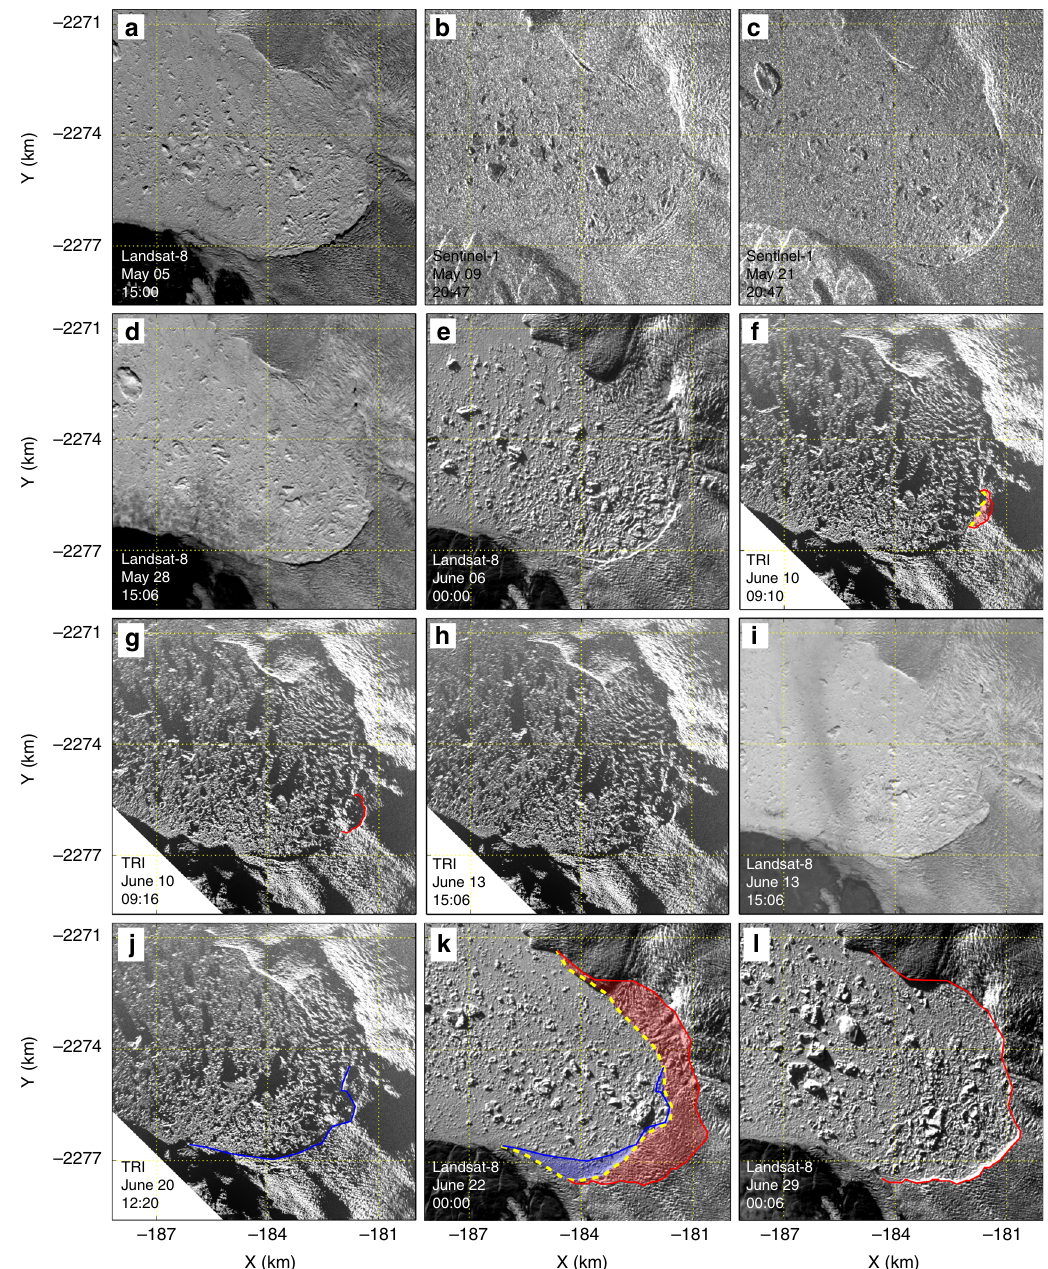
Fig. 3 Ice loss due to glacier calving events by inspection of TRI and satellite images. For each subplot, lower left text gives platform of data source and acquisition time in 2016. In f , dashed yellow line shows a cliff segment which later retreated to the red lines shown in f and g , red shade shows the ice loss area due to that small calving event between f and g . Blue lines in j and k show cliff location at 12:20 20 June 2016. Red lines in k and l show location of the cliff at 00:06 29 June 2016. Dashed yellow line in k shows cliff location at 00:00 22 June 2016. Shaded blue and red in k show areas of ice loss due to calving events from digitized cliff locations. Note glacier front advanced by ~1 km between c and